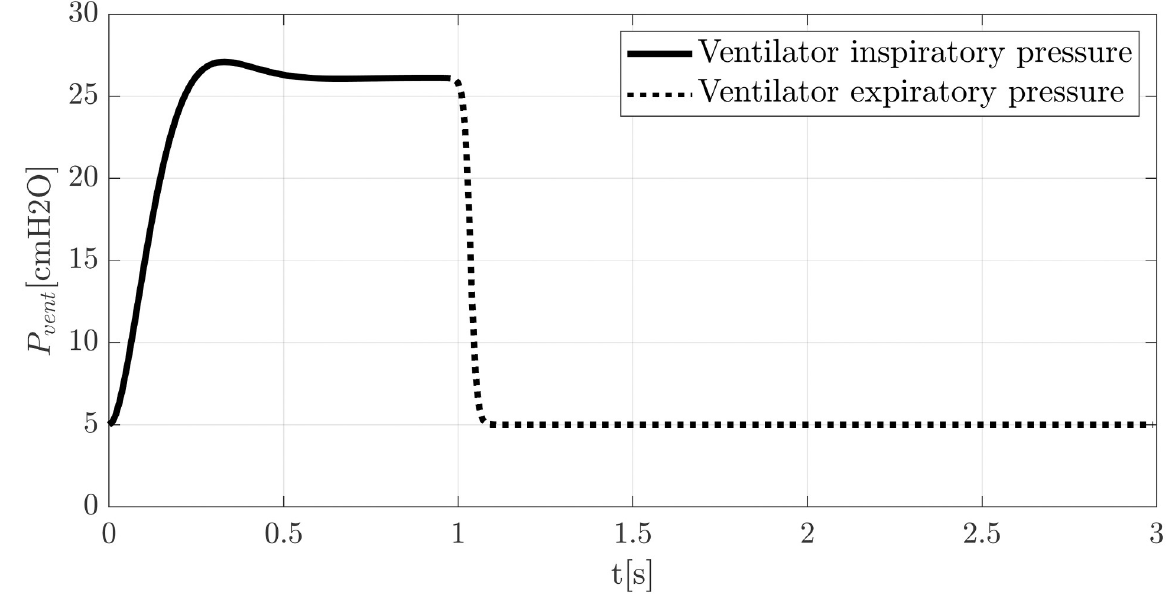
Fig 5. Typical waveforms of pressure signals for inspiratory and expiratory